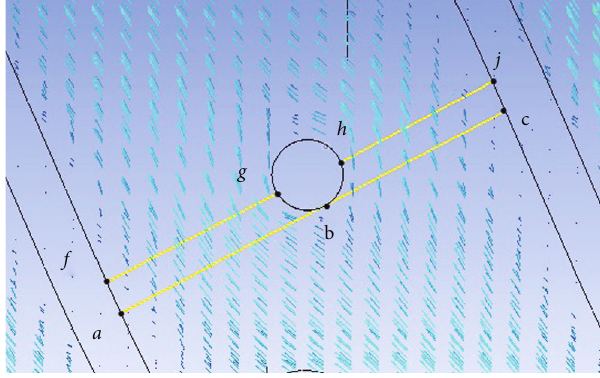
Figure 6: Velocity vector nephogram of the mixing section ( D = 150 mm ).